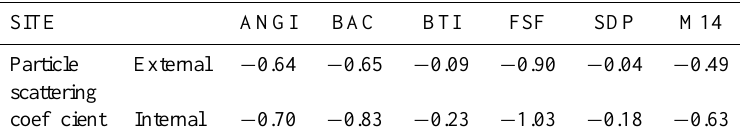
Table 2. Mean fractional biases (MFB) of particle scattering coefficient predicted by external run and internal run at 6 observation sites